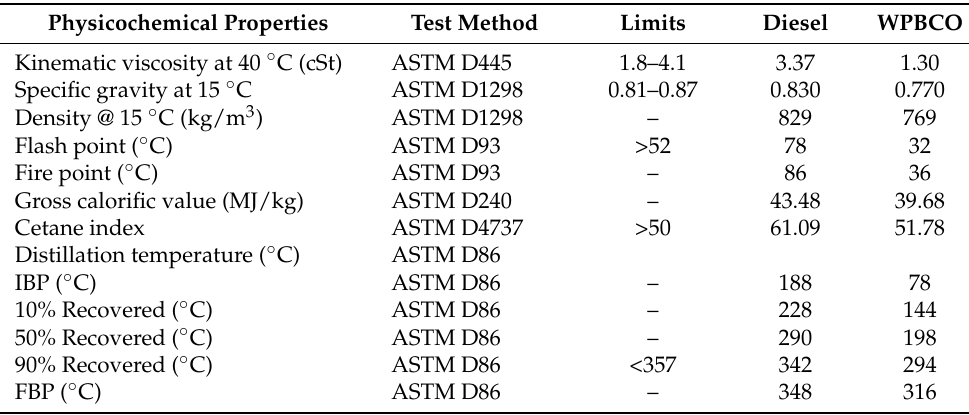
Table 7. Physicochemical properties of diesel fuel and WPBCO. Physicochemical